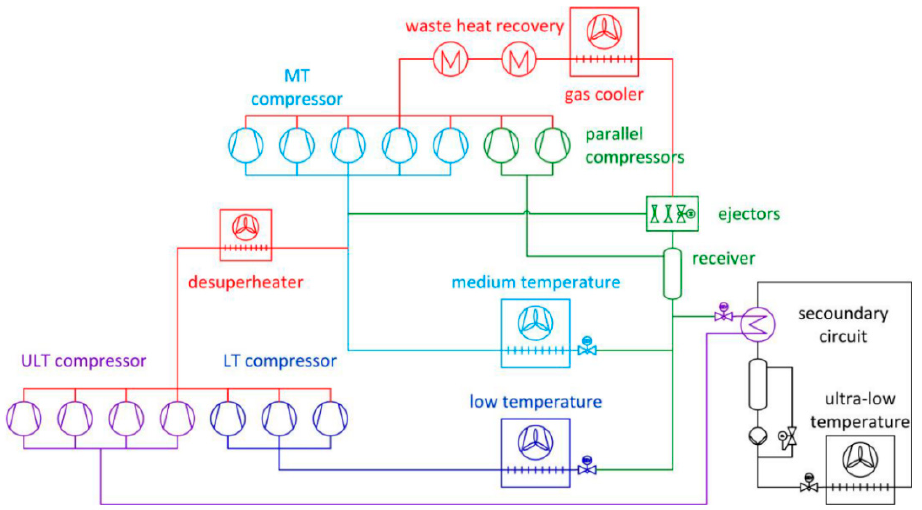
Figure 27. Schematic of the multi-ejector based “CO 2 only” vapor-compression systems installed in a fish processing plant in Valencia ( t MT = +2 °C, t LT = -20 °C, t ultra LT = -40 °C, 𝑄(cid:4662) (cid:3047)(cid:3042)(cid:3047)(cid:3028)(cid:3039) = 764 kW) [74].